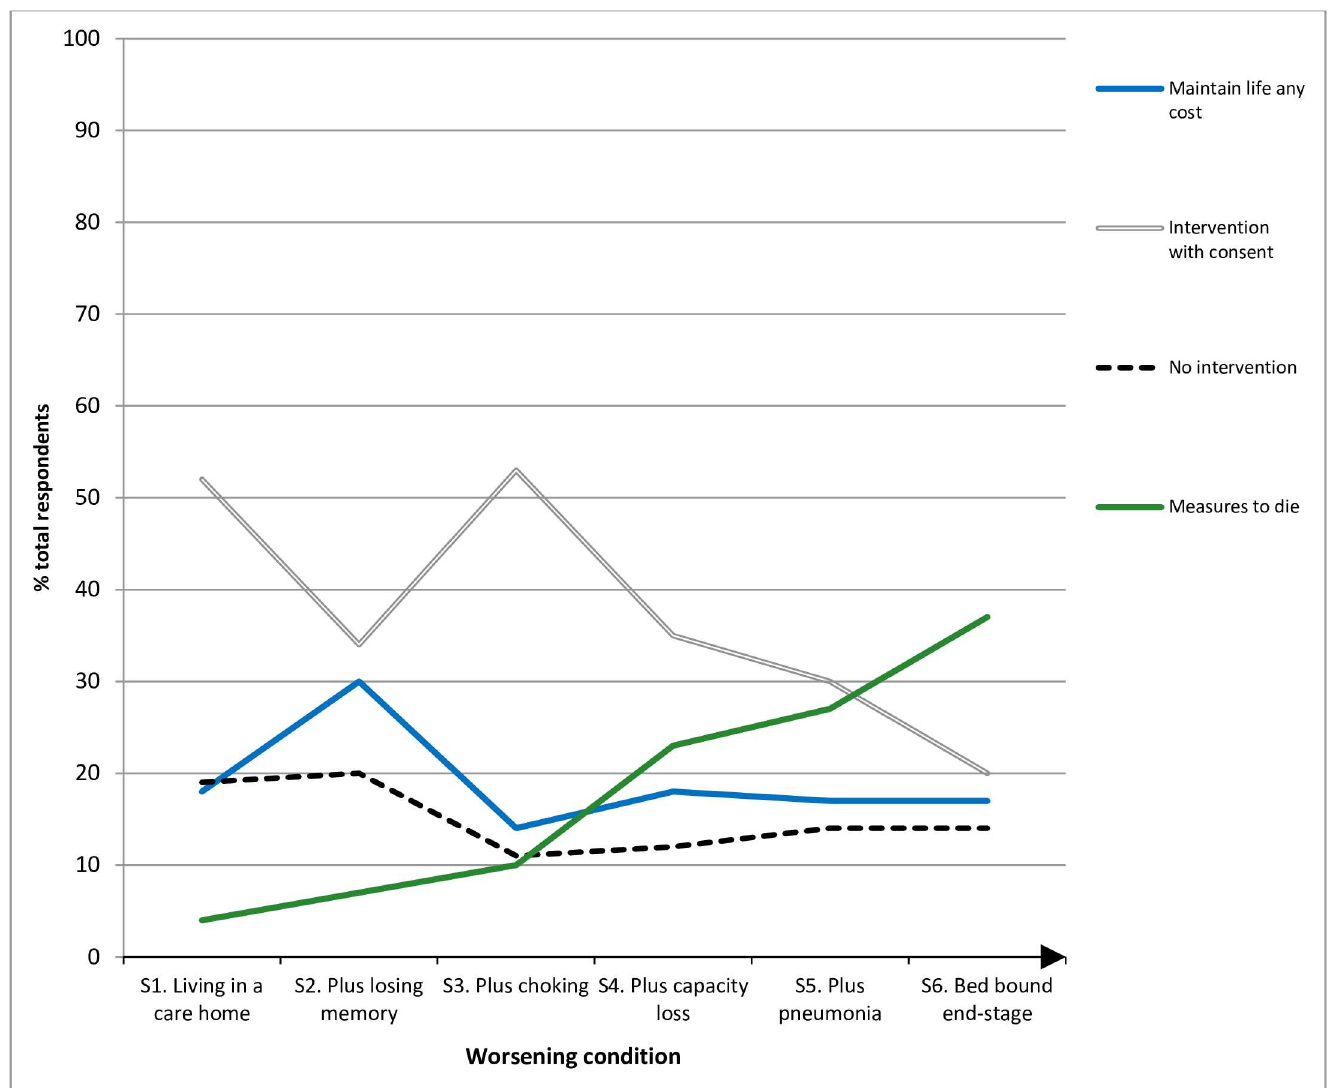
Fig 1. Percentage of respondents’ end of life preferences across six stages of the vignette scenario (N = 2016).